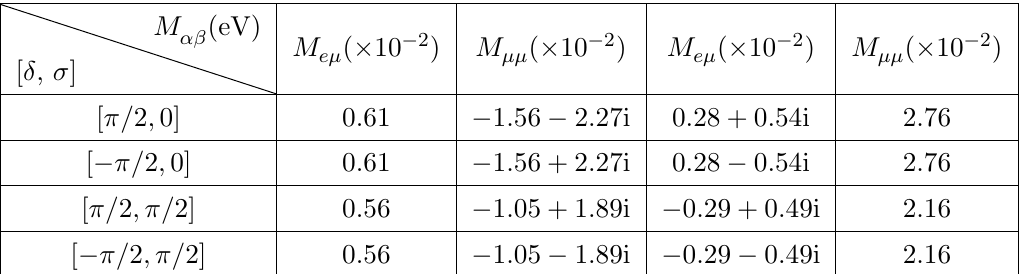
and M for various combinations of (cid:14) and (cid:27) in the NH case, e(cid:22) (cid:22)(cid:22)